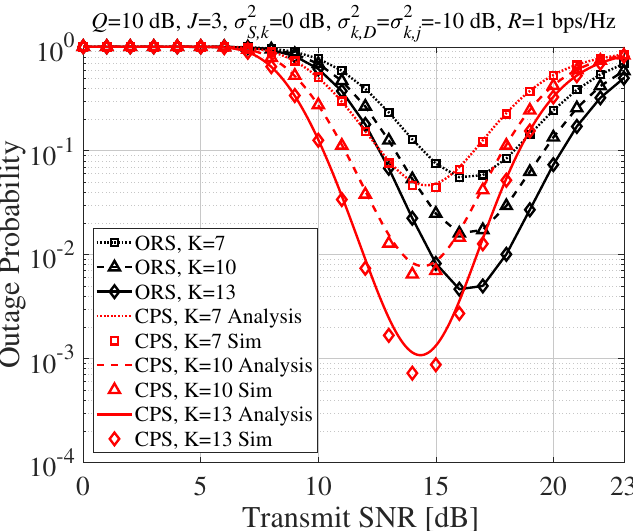
Figure 2. Outage probability according to the transmit SNR (dB). ORS, opportunistic relay selection; CPS, cooperative phase-steering; Sim,